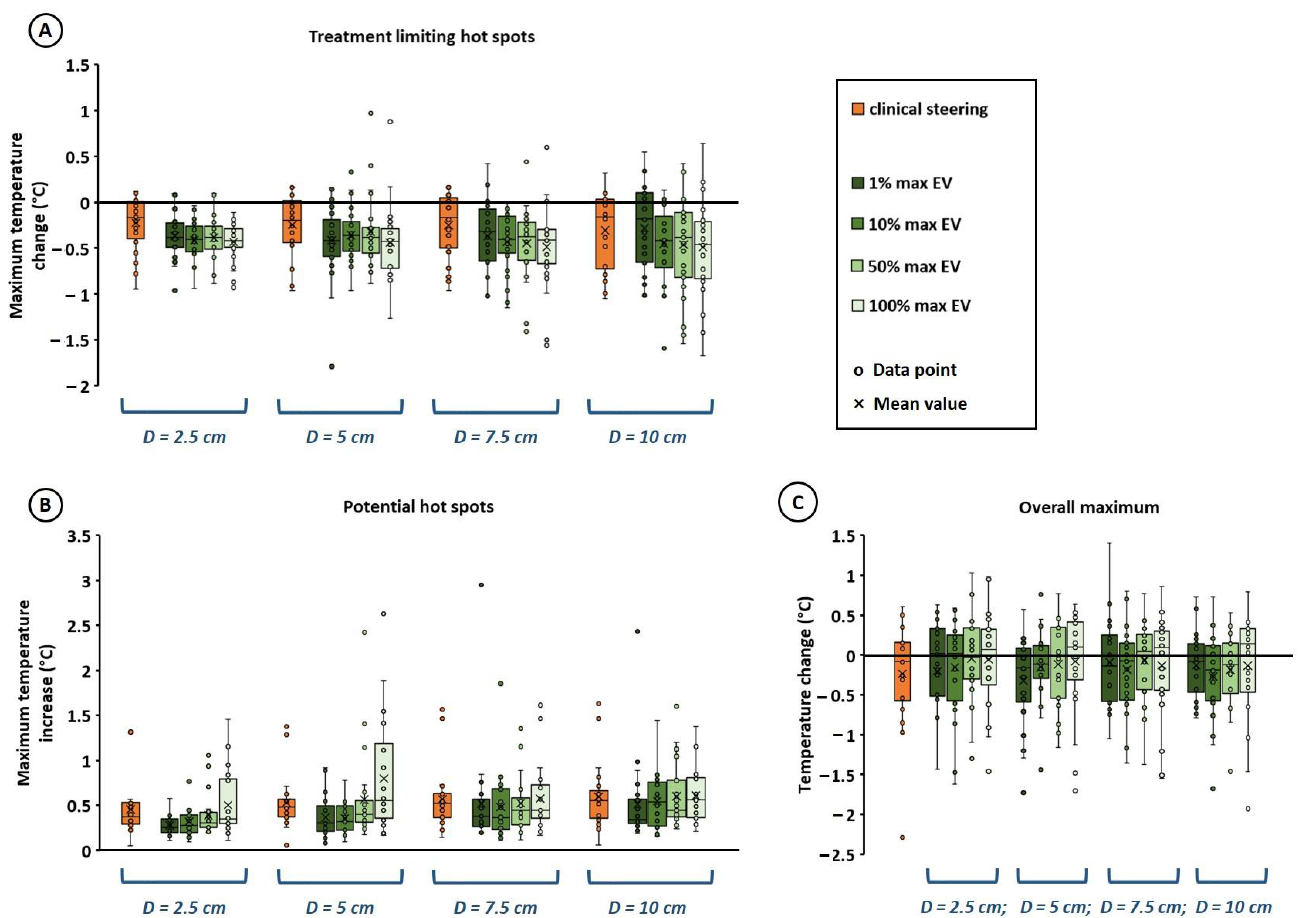
Figure 4. Effect of potential hot spot diameter ( D = 2.5, 5, 7.5 or 10 cm) on the predicted temperature at treatment limiting hot spot locations ( A ), other potential hot spot locations ( B ) and the overall maximum temperature ( C ), when using a re-optimization goal function with a penalty term for the maximum increase of all potential hot spot temperatures (Equation (3). Results are compared to simulations for the clinically applied protocol/experience-based steering strategy during treatment. To efficiently calculate a hot spot temperature during optimization, the average temperature of the voxels with the x% largest heating potential was calculated, which are the voxels with the largest maximum eigenvalues (EV) of their temperature matrix ( T in Equation (2). Values of x of 1, 10, 50 and 100% were evaluated.